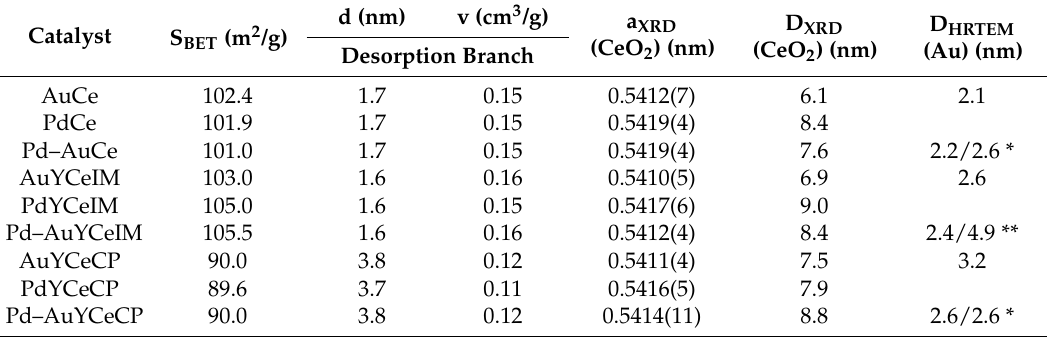
Table 1. Specific surface area (S BET ), mean pore diameter (d) and pore volume (v), as estimated by physisorption measurements; lattice constant of ceria (a) and average size of ceria crystallites (D XRD ) estimated by X-ray powder diffraction (XRD); gold particle sizes (D) estimated by High resolution transmission electron microscopy (HRTEM)/ high-angle annular dark-field